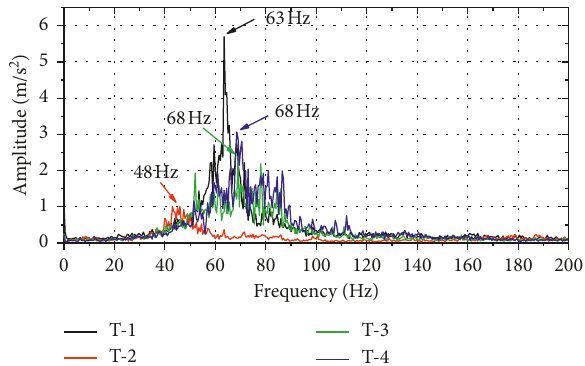
Figure 6: Frequency spectral of the vertical axlebox accelerations on different types of tracks (T-1 for monolithic concrete bed with DTVI2 fasteners, T-2 for monolithic concrete bed with com- pression-type fasteners, T-3 for low-weight floating slab track, and T-4 for floating slab track with high